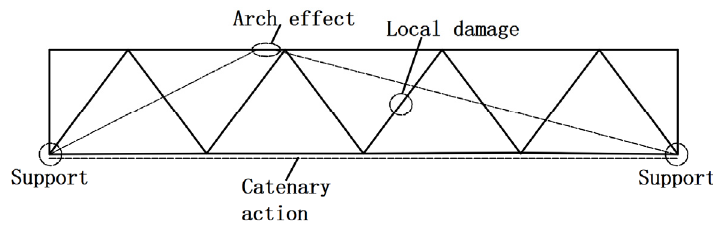
Figure 13. Two mechanisms after the failure of the web member.